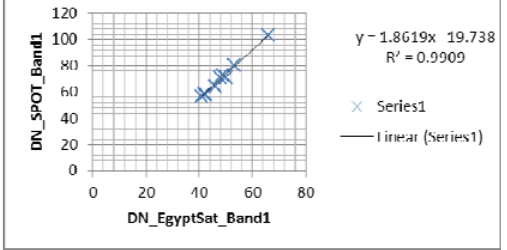
Knowing the recent gain and offset of the Spot-4 sensor, Table 4 lists the estimated calibration coefficients (Gain and Offset) for Egyptsat-1 for the three different